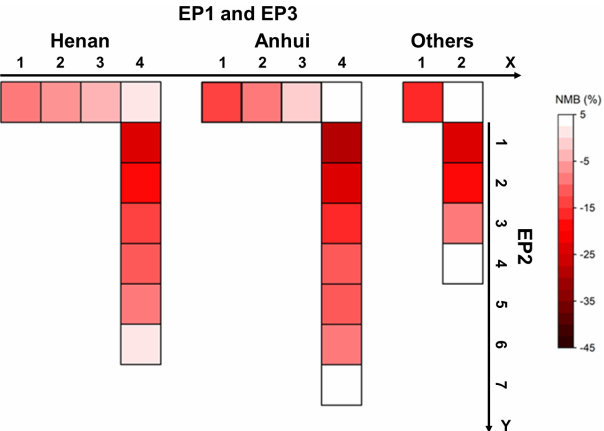
Figure 7. Model responses to dynamic emission perturbations. Col- ored cells represent NMBs between observed and simulated PM 2 . 5 concentrations in different model sensitivity tests for Henan, Anhui, and other provinces over CEC. Coefficients on the x axis refer to the adjustment coefficients for OBB emissions in EP1 and EP3, while coefficients on the y axis denote the ones for